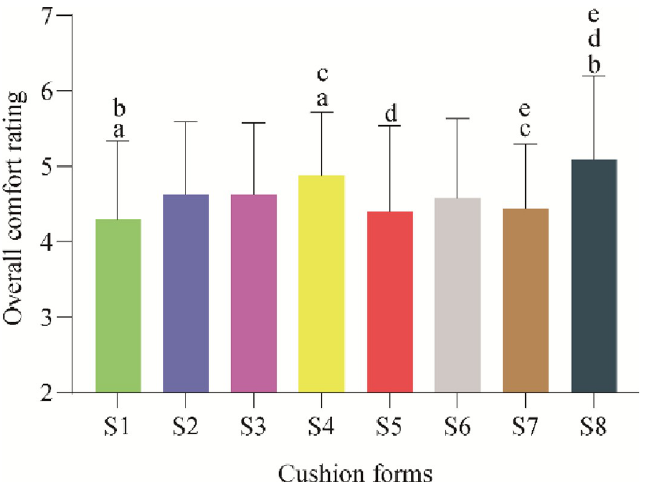
Fig 10. The overall comfort rating score for eight cushion contours averaged over 97 participants, bars with the same letter superscript represent the significant difference (p <